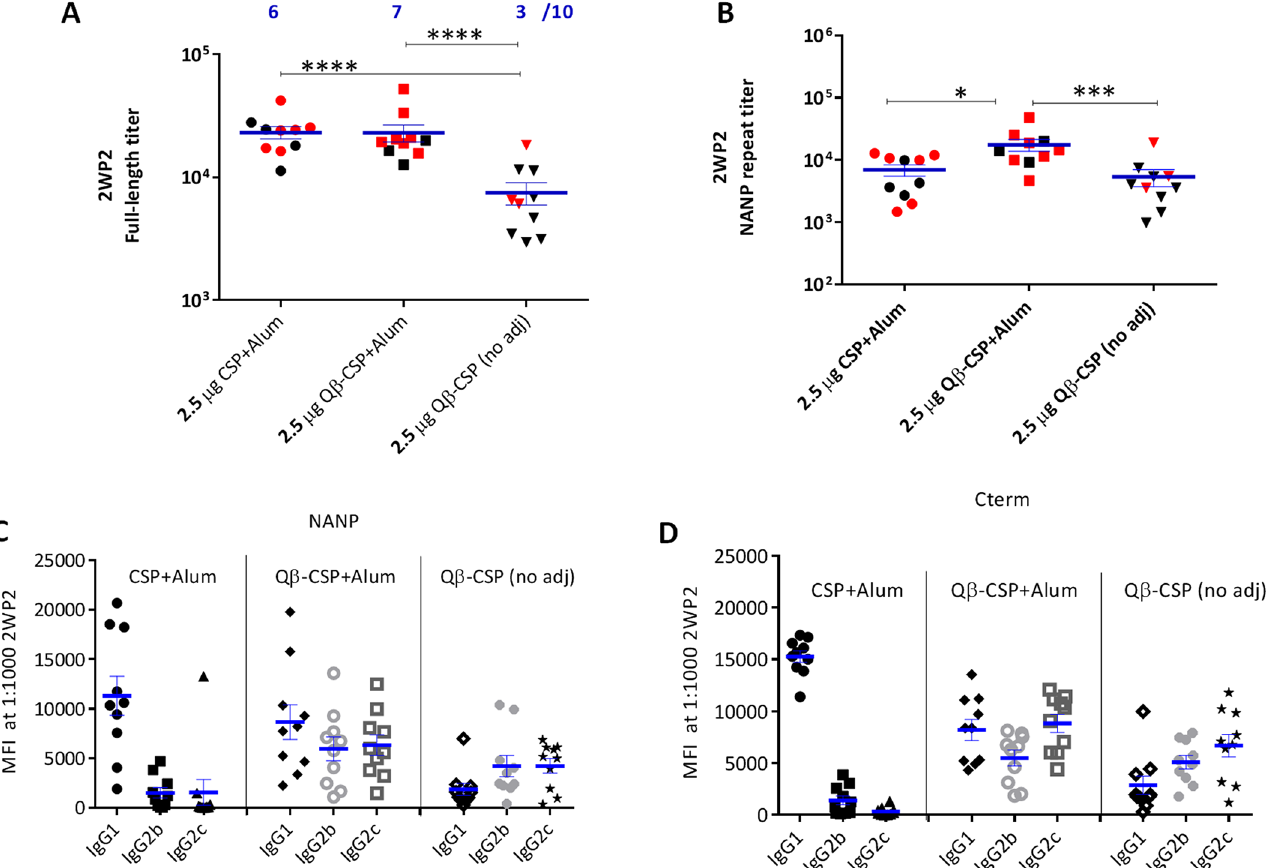
Fig 4. Q β -CSP vs . CSP in Alum. Groups of 10 mice received 2 doses, 3 weeks apart of 2.5 μ g CSP+Alum, Q β -CSP+Alum or Q β -CSP without an adjuvant. A, B show the mean ± SEM of the full-length and NANP-specific ELISA titers at 2 weeks after the second vaccination. **** (p < 0.0001); *** (p < 0.001); * (p < 0.05); red symbols represent protected mice and number (blue) protected out of 10. C, D, show the IgG1, IgG2b and IgG2c responses measured by Luminex and expressed as MFI at 1:1000 dilution against NANP peptide (C) or C-term protein (D).